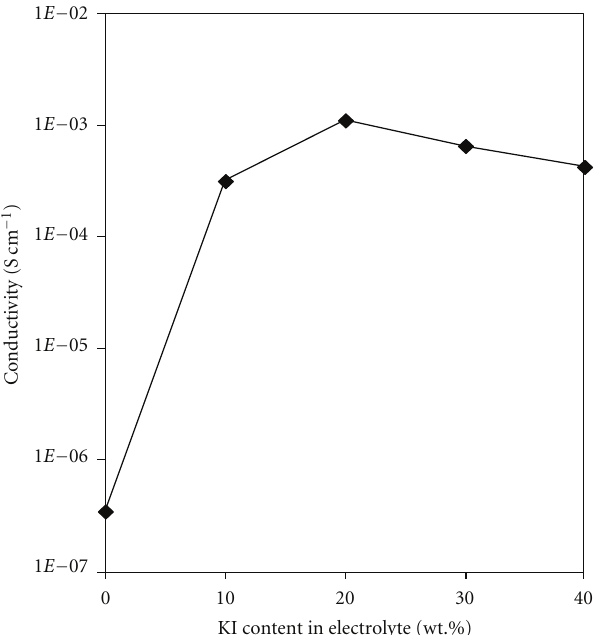
Figure 1: Conductivity of PVDF-HFP electrolyte with di ff erent salt contents.